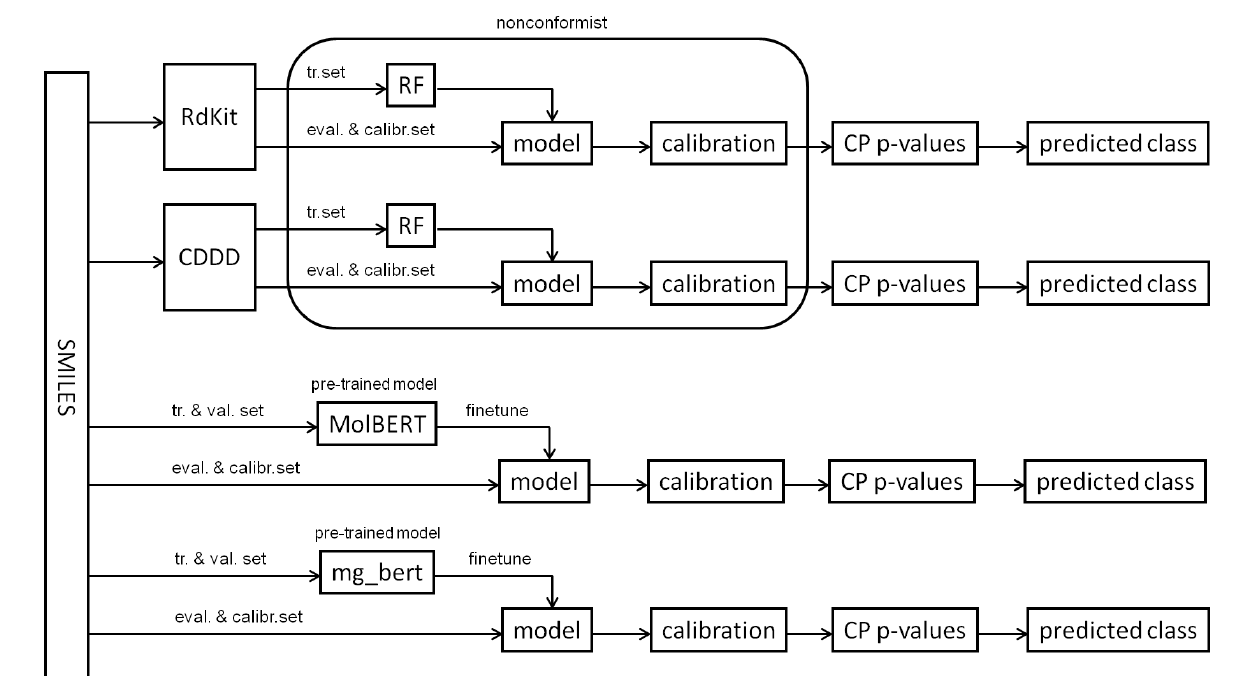
Figure 1. A flow chart overview depiction of the employed machine learning approaches. RdKit and CDDD = RdKit and CDDD descriptor calculation, tr. and val. set. = training and validation set, respectively, eval. and calibr. set. = evaluation and CP calibration set,